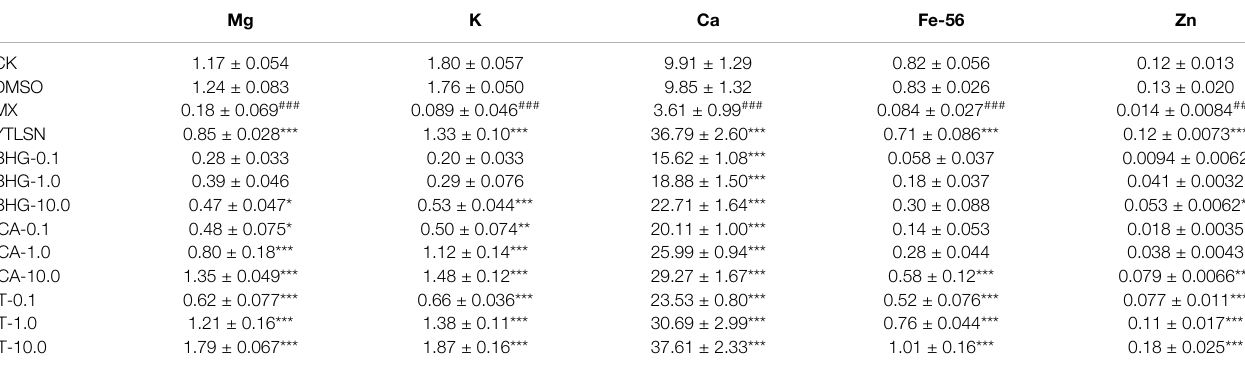
TABLE 4 | Effect of ICA, IT, and BHG-I on the mineral contents in zebra fi sh